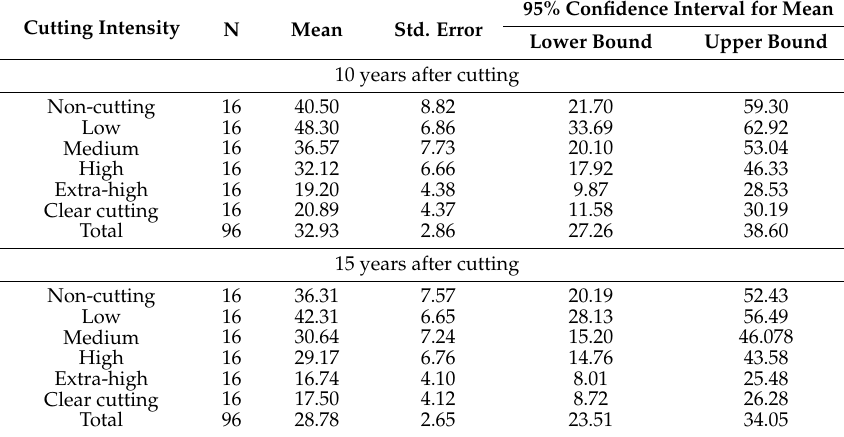
Table 7. Descriptive statistics of impacts of cutting intensity on overall soil properties.